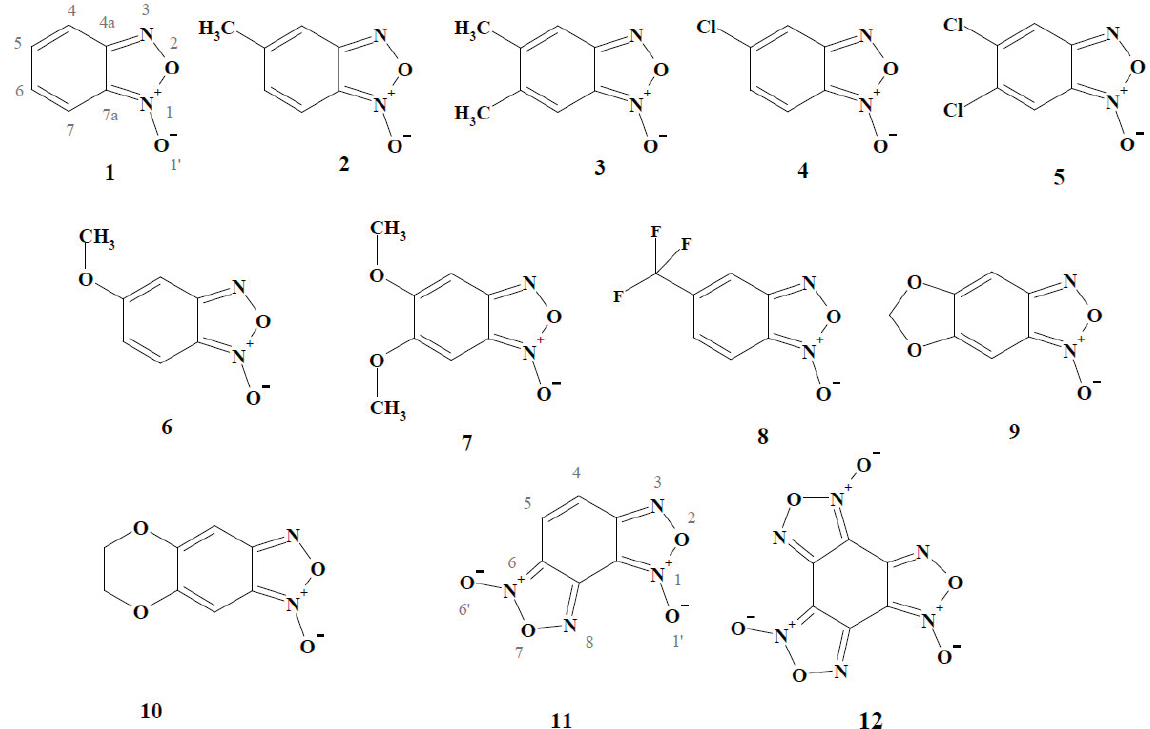
Figure 1. Structural formulas of benzofuroxan compounds used in the